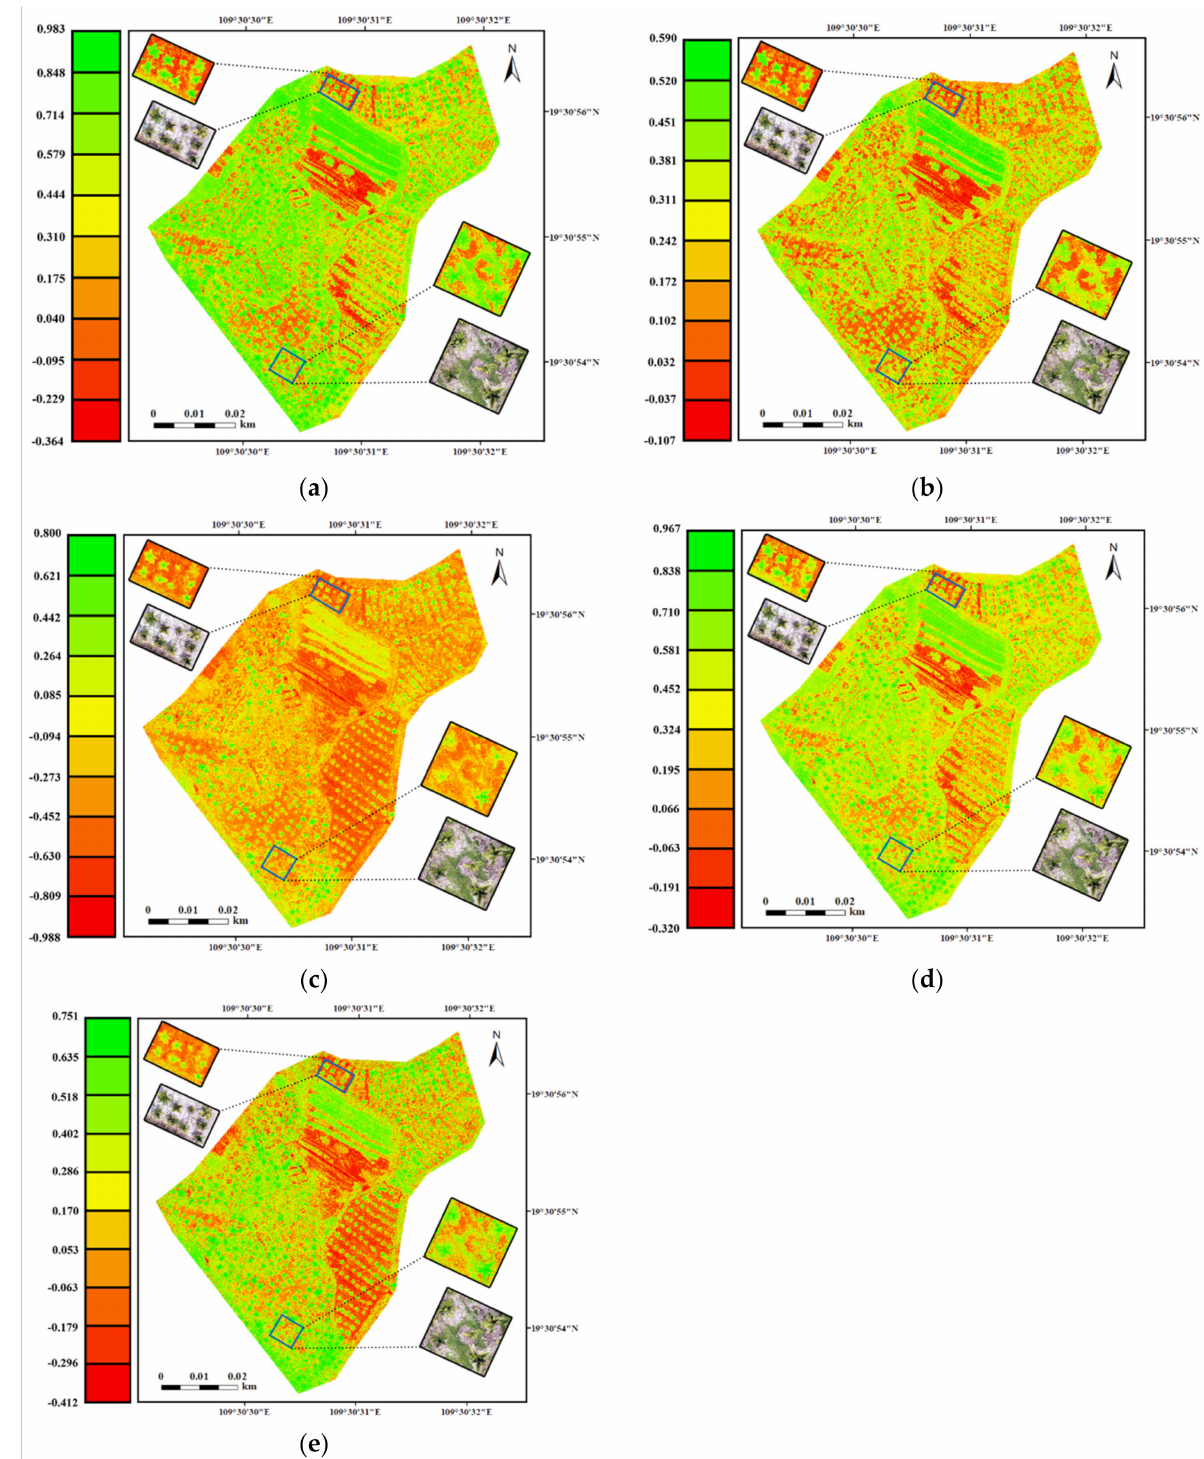
Figure 6. Areca forest vegetation index: ( a ) NDVI; ( b ) OSAVI; ( c ) LCI; ( d ) GNDVI; ( e ) NDRE. The DJI Terra software is used to import 1237 high-resolution UAV images, perform orthorectification and image mosaic on the UAV images, and obtain DOM and DSM in the research area with a spatial resolution of 0.01 m (Figure 7). The optimized camera radial distortion parameters are − 0.28180304, 0.12019049, and − 0.03154244, and the optimized camera tangential distortion parameters are 0.00001891 and − 0.00006844. The RMSE between the calculated image position and the position recorded in the image was 0.031